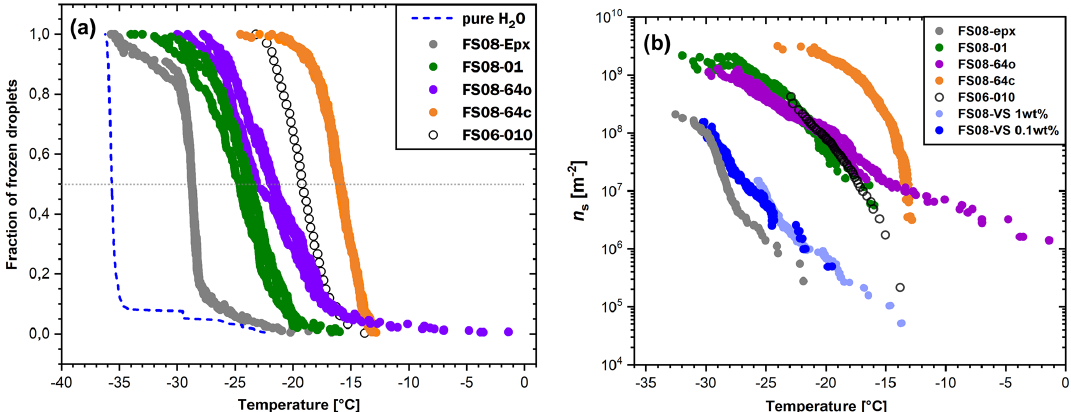
Figure 4. Results of the droplet-freezing experiments. (a) Fraction of frozen water droplets as a function of supercooling temperature. The cooling rate was 3K/min in all experiments. Pure water droplets on a clean silicon wafer freeze within a small temperature range between − 35 and − 36 ◦ C (as shown by the blue dashed curve). (b) INAS density calculated from the data shown in (a) . In addition, the INAS density calculated for the untreated Volkesfeld sanidine (sample FS08-VS) obtained from suspension droplet-freezing experiments is shown for comparison in two different shades of blue for the two weight concentrations (dark blue for 0.1wt% and light blue for 1wt%).